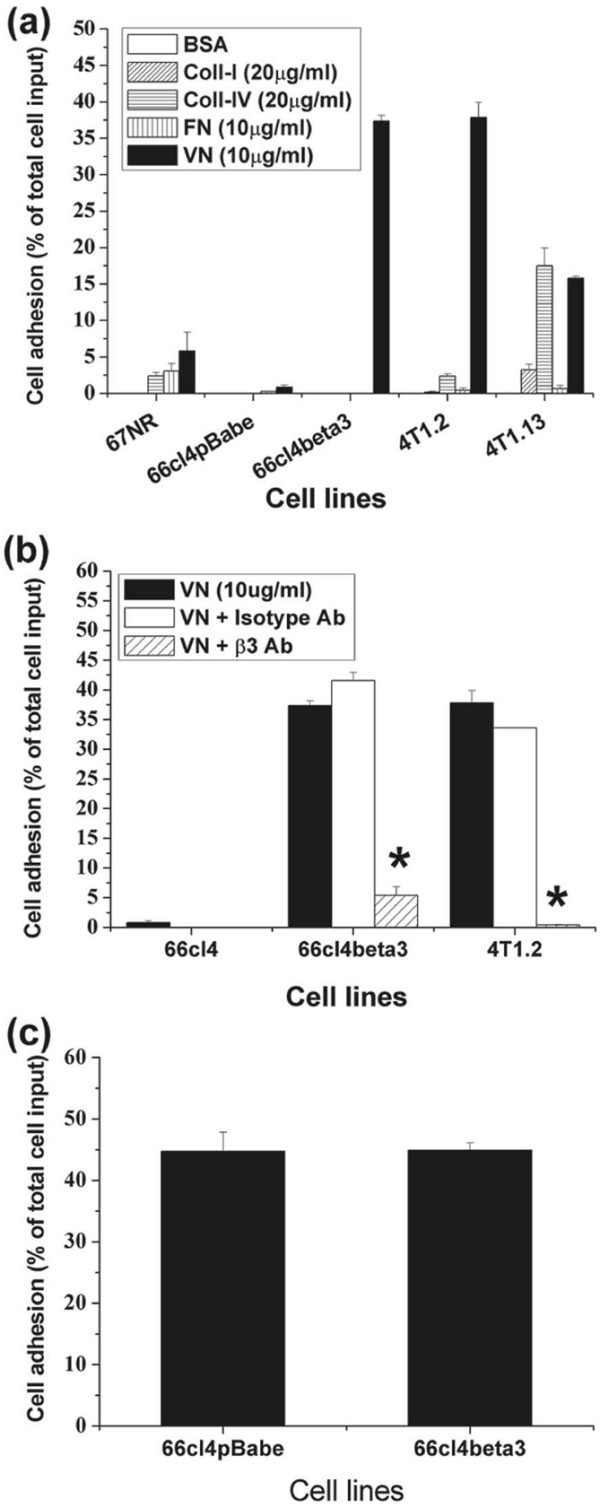
αvβ3 integrin mediates mammary tumor cell adhesion to vitronectin but not to endothelial cells. (a) Short-term adhesion to different matrices. (b) Effect of neutralizing antibodies against β3 integrin on short-term adhesion to vitronectin. (c) Adhesion of 66cl4pBabe and 66cl4beta3 cells to a monolayer of bEnd.3 endothelial cells in the absence of serum. The experiments were repeated at least twice and the results represent the mean ± standard deviation of a representative experiment performed in triplicate wells. *P < 0.001.